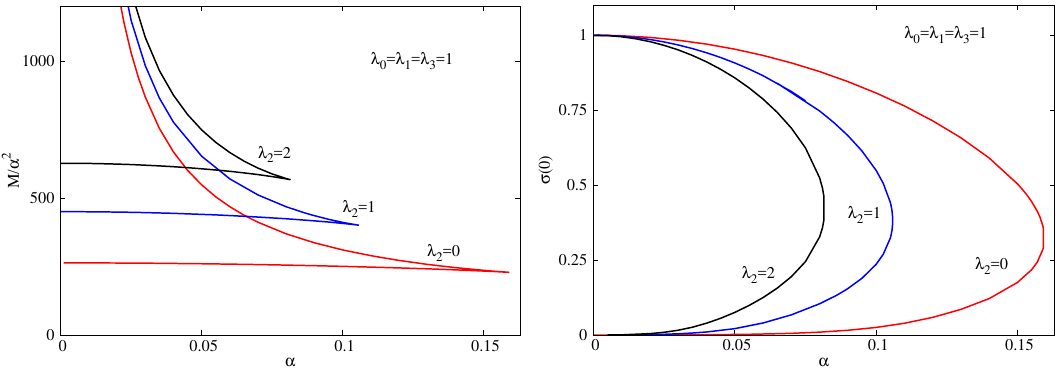
Figure 13 . The mass M (left panel) and the parameter (cid:27) (0) (right panel) are shown as a function of the coupling constant (cid:11) , for Skyrme stars in our model with di(cid:11)erent values of (cid:21) 2